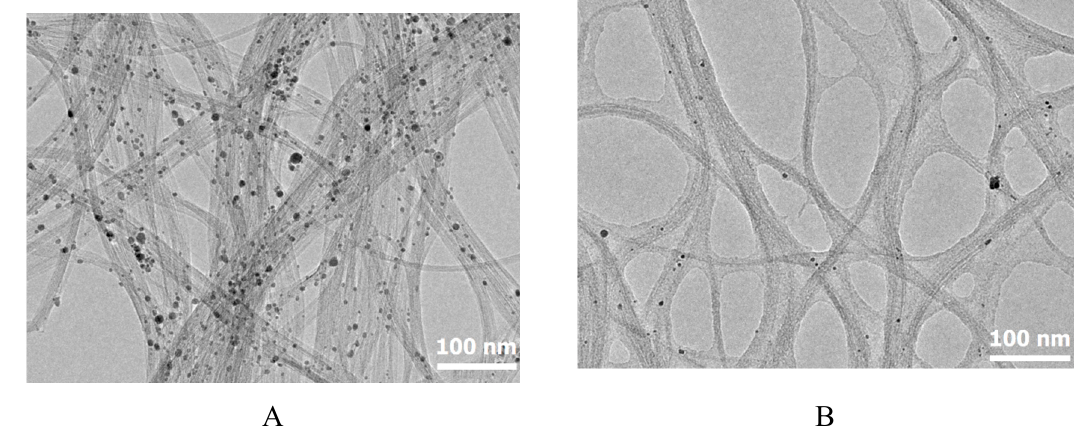
Figure 4. CNT TEM images. before ( A ) and after ( B ) CO 2 processing at a pressure of 75 bar and a temperature of 80 °C.